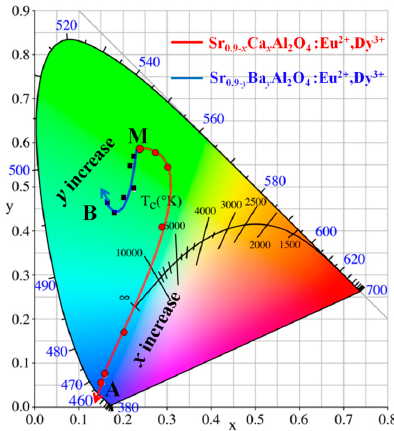
Figure 3 . CIE chromaticity diagram of Sr 0.90 − x Ca x Al 2 O 4 :0.05Eu 2+ , 0.05Dy 3+ and Sr 0.90 − y Ba y Al 2 O 4 :0.05Eu 2+ , 0.05Dy 3+ phosphors with various x (or y ) values ( x , y = 0.00–0.90). Table 1 . Color coordinates of Sr 0.90 − x Ca x Al 2 O 4 :0.05Eu 2+ , 0.05Dy 3+ and Sr 0.90 − y Ba y Al 2 O 4 :0.05Eu 2+ , 0.05Dy 3+ phosphors ( x , y = 0.00–0.90).